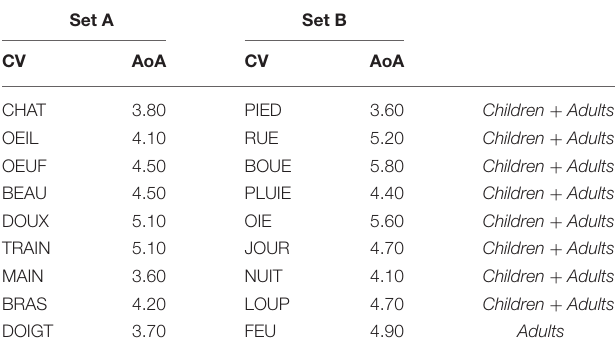
TABLE 1 | Stimuli material for Experiment